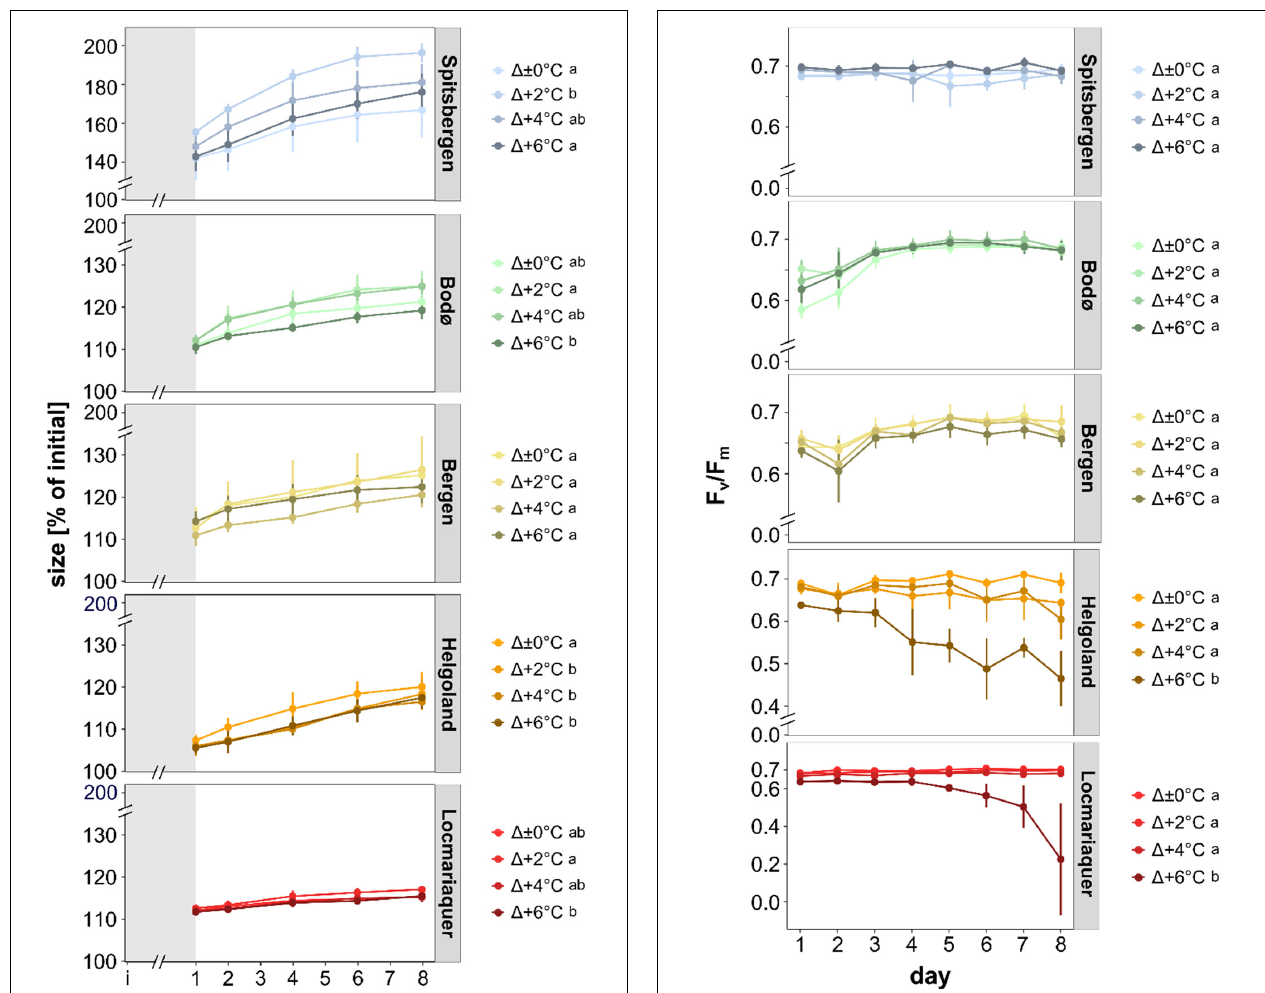
increasing temperatures of (cid:49) + 6 ◦ C (AT > 23 ◦ C). Clear